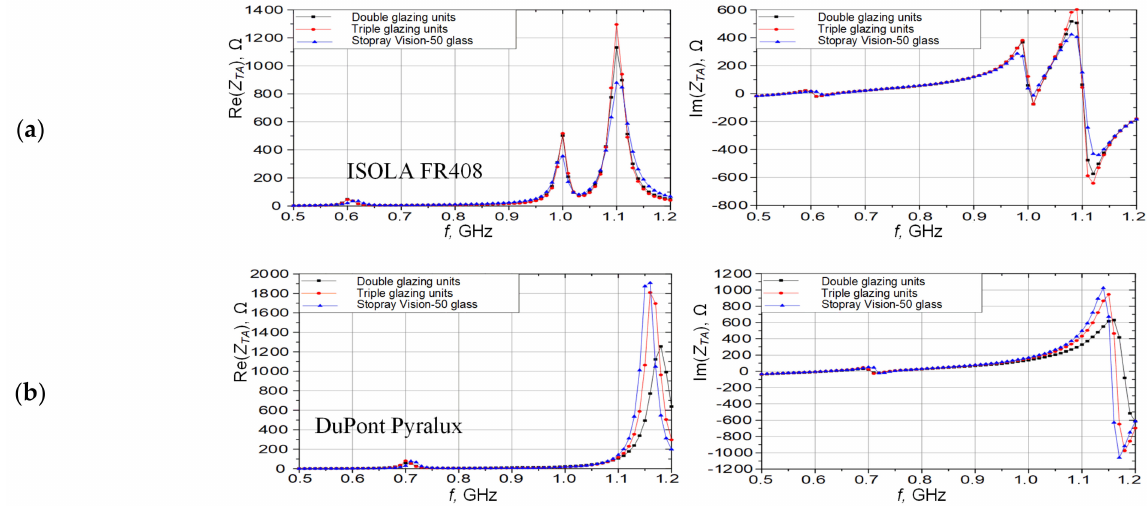
Figure 11. Impedance of RFID antenna located in different arrangements ( a ) ISOLA FR408; ( b ) DuPont